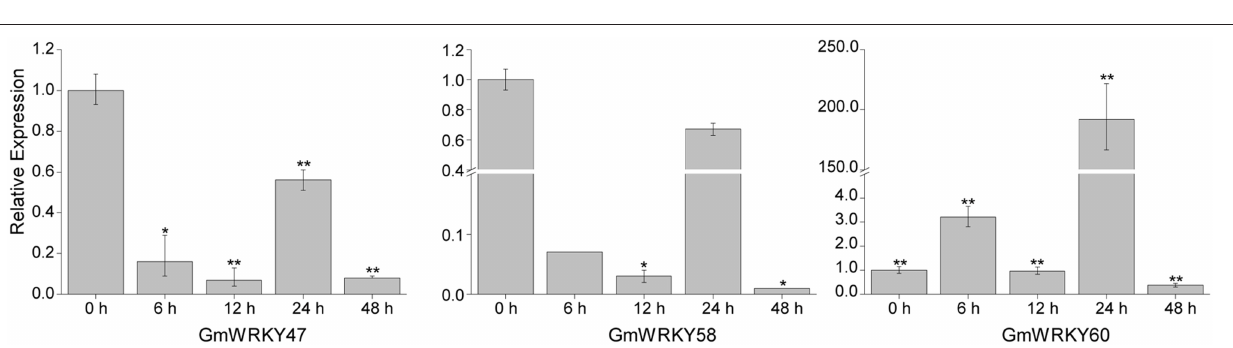
FIGURE 10 | Expression pattern of selected GmWRKY genes under dehydration stress. The Y-axis indicates the relative expression; X-axis (0, 6, 12, 24, and 48h) indicates hours of dehydration treatment. The standard errors are plotted using vertical lines. * significant difference at P < 0.05 , ** significant difference ( P < 0.01 ).